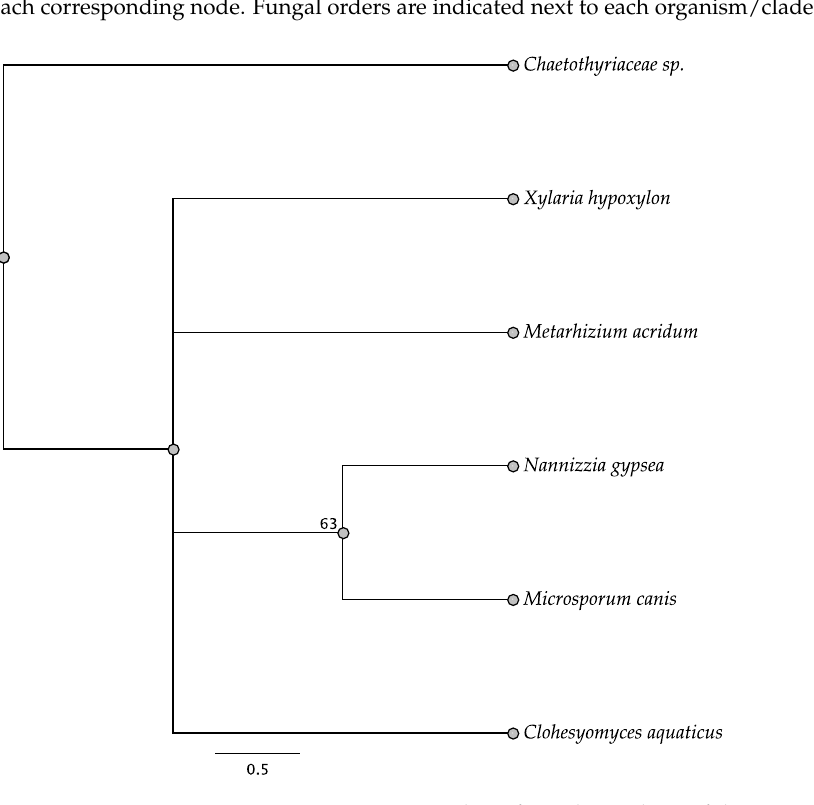
Figure 13. Maximum parsimony DNA tree resulting from the analysis of the swnN – swnH1 inter- genic region sequence data. Bootstrap confidence values from 1000 bootstrap replicates are pre- sented at each corresponding node. Fungal orders are indicated next to each organism/clade.